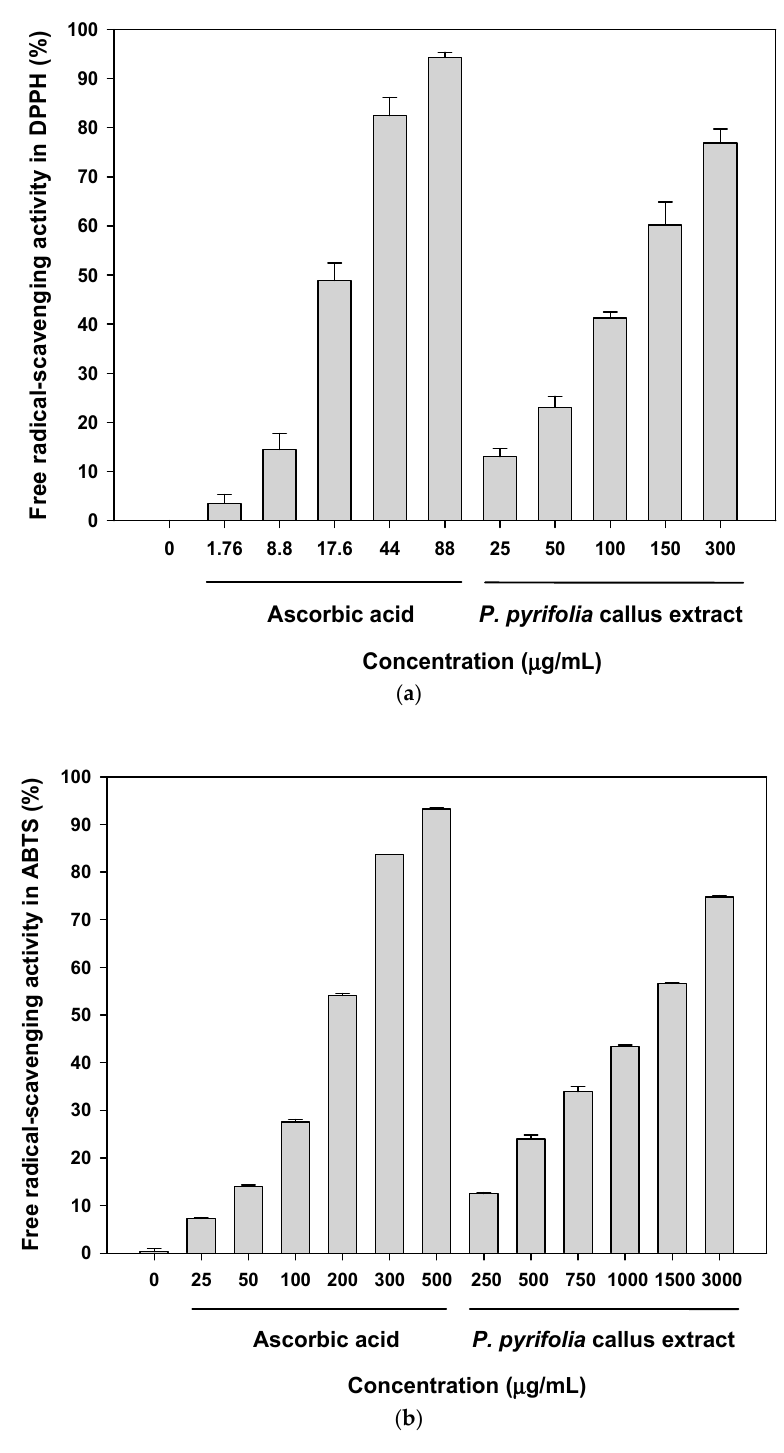
Figure 2. Antioxidant activity of the aqueous extract of P. pyrifolia callus. ( a ) 2,2-Diphenyl-2-picrylhydrazyl (DPPH) and ( b ) 2,2 ′ -azinobis-(3-ethylbenzoline-6-sulfonate) (ABTS) free radical scavenging activity. Values are the means ± standard deviation ( n = 6 per group).